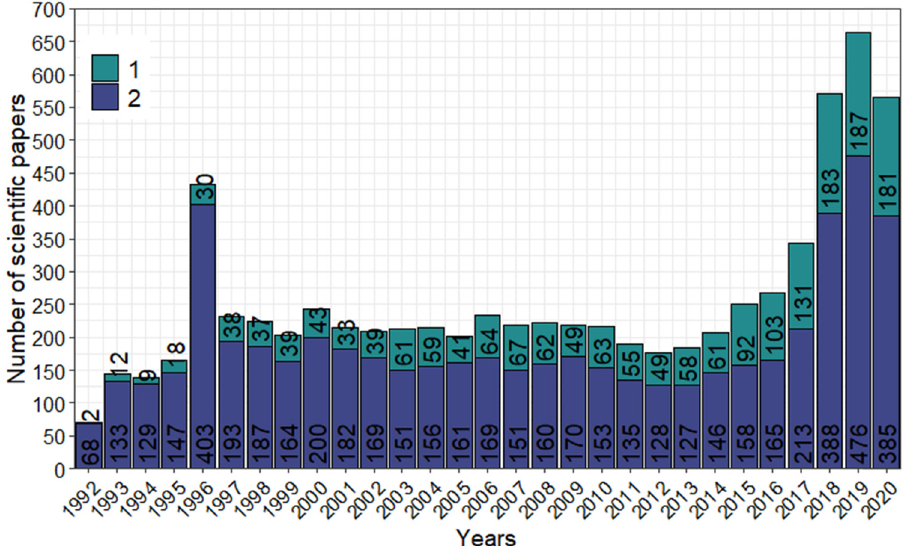
Figure 3: The number of scienti fi c papers distributed by years, from 1992 to 2020. ( 1 ) By Russian authors co - authored with foreign authors. ( 2 ) By Russian authors only. Source: Own calculation using R software 4.0.2 ( 2021 ) based on the data aggregated by the Clarivate Analytics, WoS Core Collection ( 2021 )